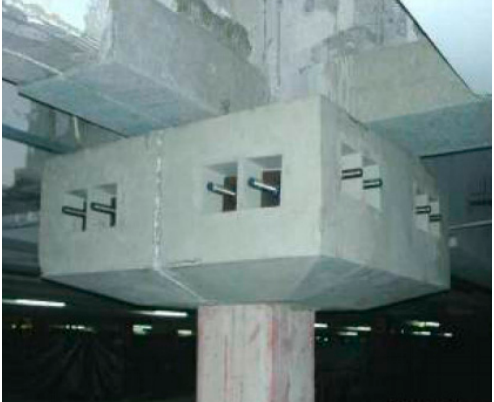
Figure 1. Corbel strengthened using prestressing bars (Source: Voumard [1]).